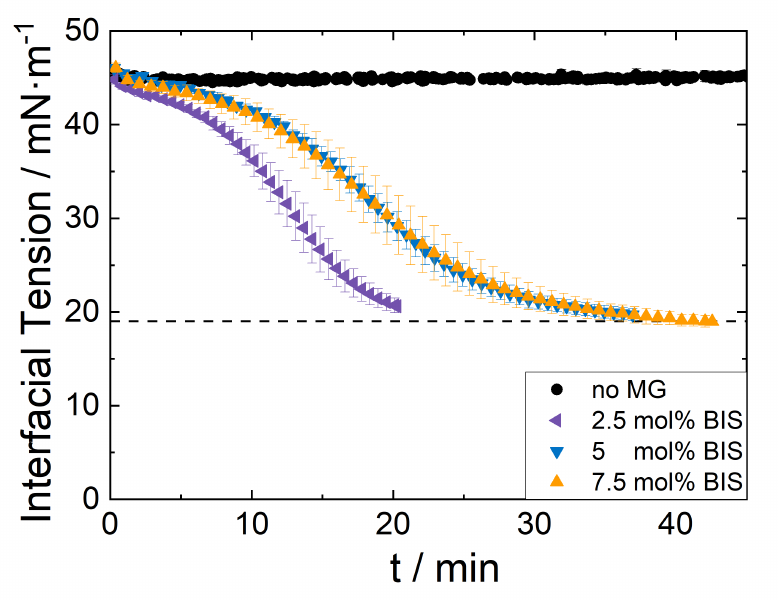
Figure 1. Interfacial tension of a dodecene droplet injected in an aqueous MG dispersion containing the three different MG types (cross-linker (BIS) content: low cross-linked MG: 2.5 mol%, medium cross-linked MG: 5 mol%, higher cross-linked 7.5 mol%), respectively, at a concentration of 0.0025 wt%. The interfacial tension decreases faster for the lower cross-linked MGs. The medium and higher cross-linked MG attach to the interface similarly